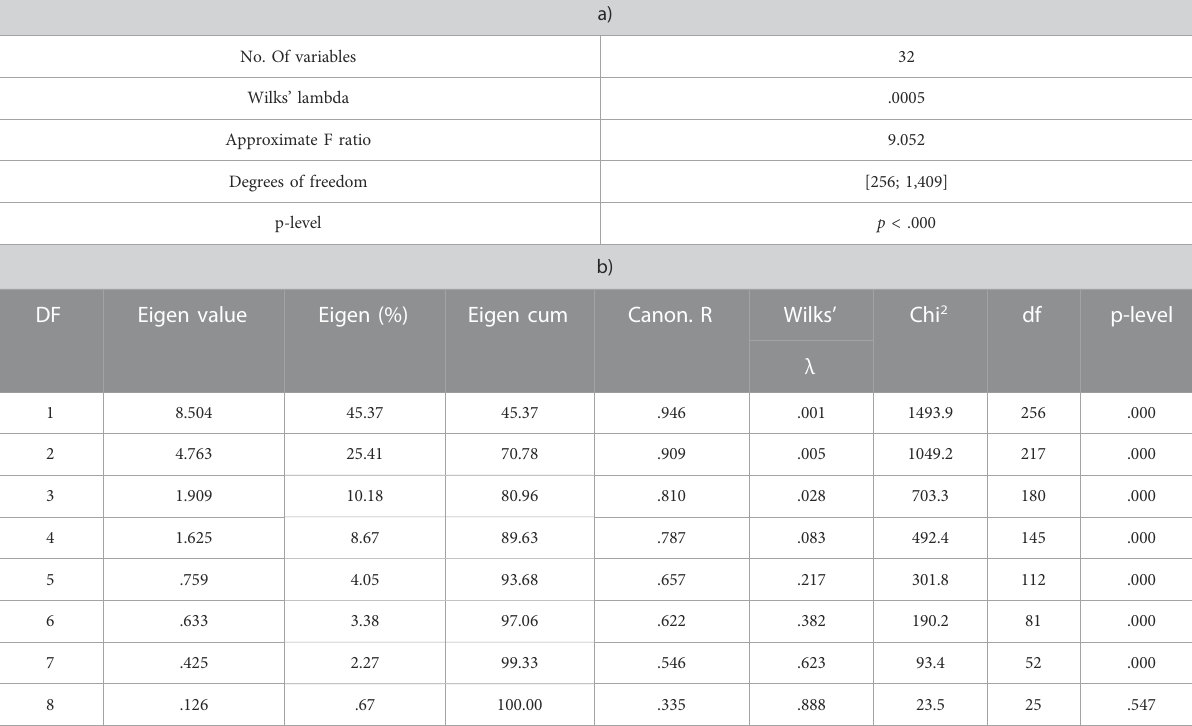
TABLE 2 Multivariate test for overall signi fi cance of discrimination (a) and tests of residual roots (b).